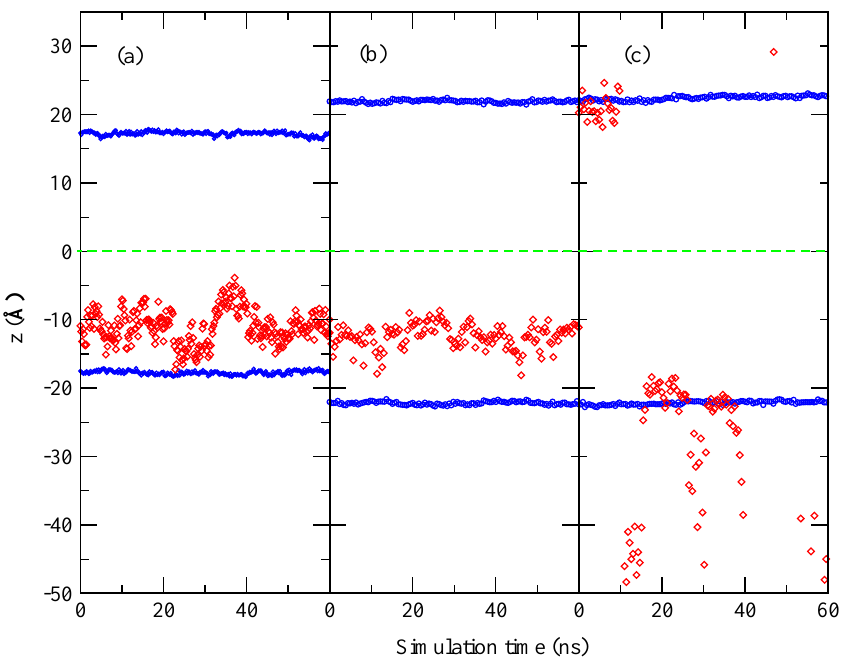
Figure 3. Z -axis location of the center of mass of MEL in a DMPC lipid membrane with different cholesterol contents as a function of simulation time. The green dashed line indicates the geometrical center of the bilayer membrane. Data partially taken from Ref. [108]. ( a ) 0% cholesterol, ( b ) 30% cholesterol and ( c ) 50% cholesterol. Red diamonds indicate the position of MEL and blue circles indicate the position of phosphorous atoms of DMPC